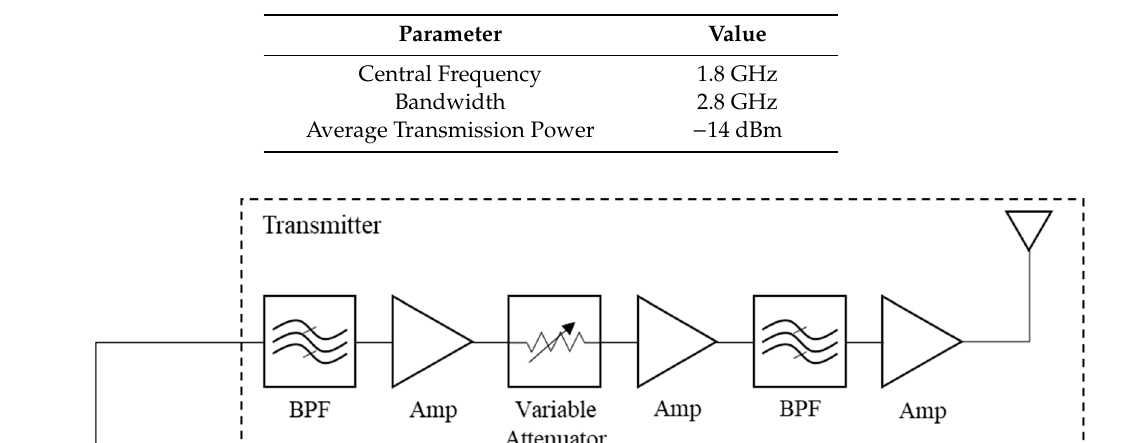
Figure 1. Ultra-wide band radar module. Table 1. NVA6100 Specifications.